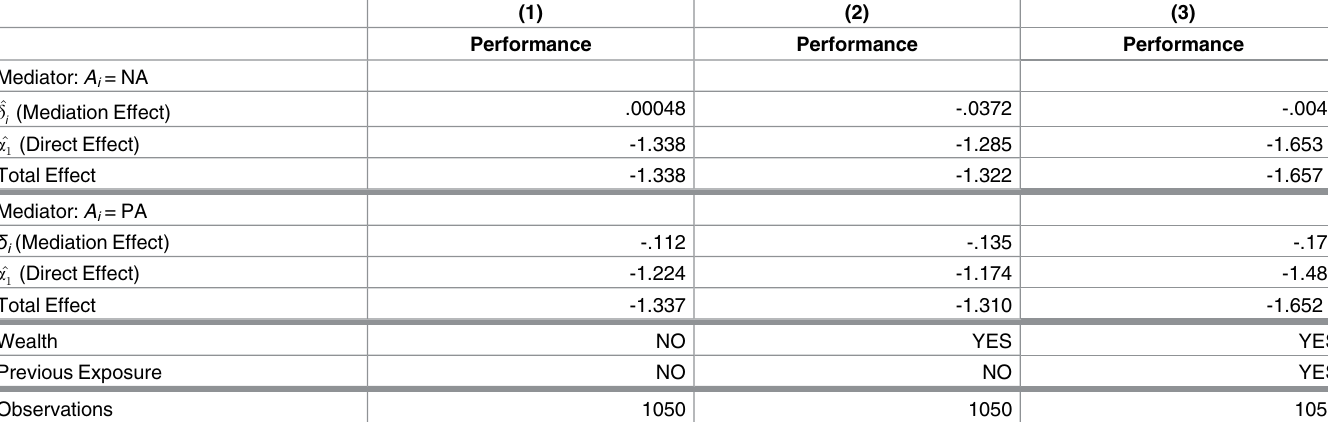
Table 8. Results of the Mediation Analysis with the General Dimension Scales PA and